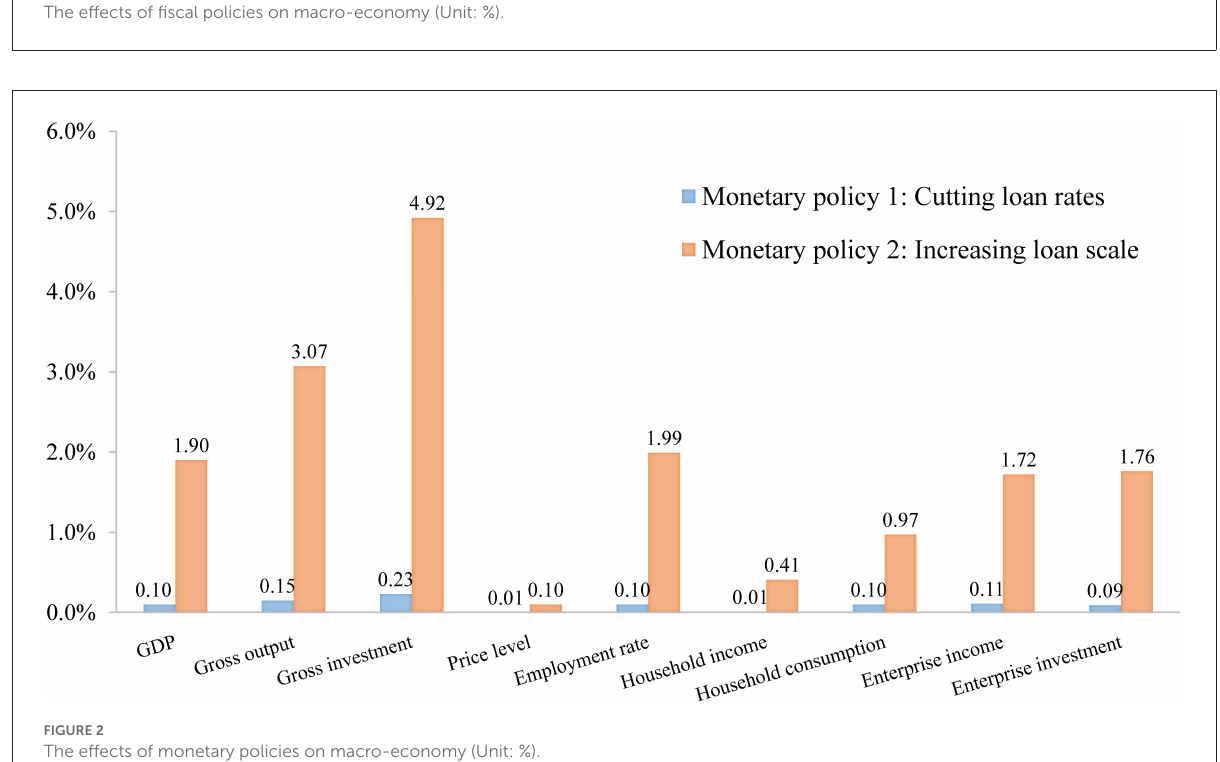
4.92% and 0.97% separately; on the supply side, increasing the scale of lending increases gross output by 3.07%. This indicates that the policy can promote economic